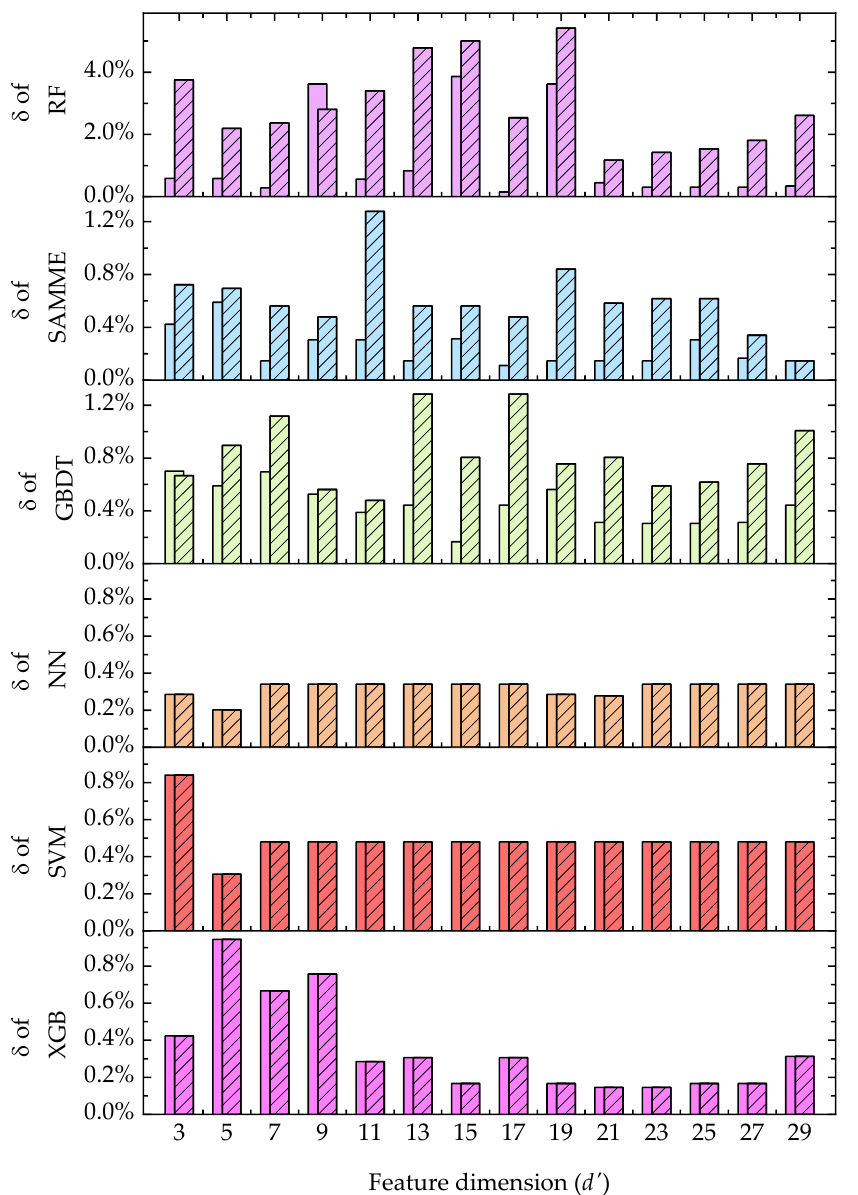
Figure 6. The variances of identification accuracies δ obtained by the six tested classification methods when the output vector dimension of PCA is set as different numbers. Bars with and without shading pattern indicate the accuracy variances obtained with the test and training sets, respec- tively.